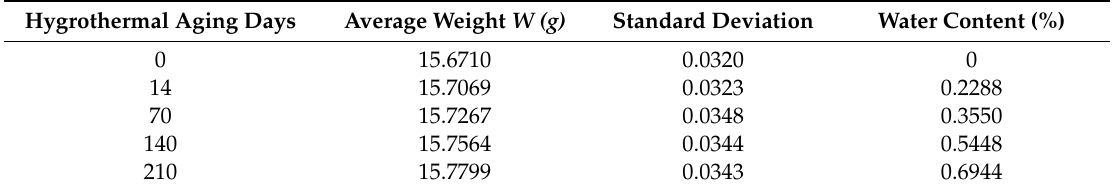
Table 1. Moisture absorption parameters of 3D four-step braided composites after di ff erent cyclic hygrothermal aging